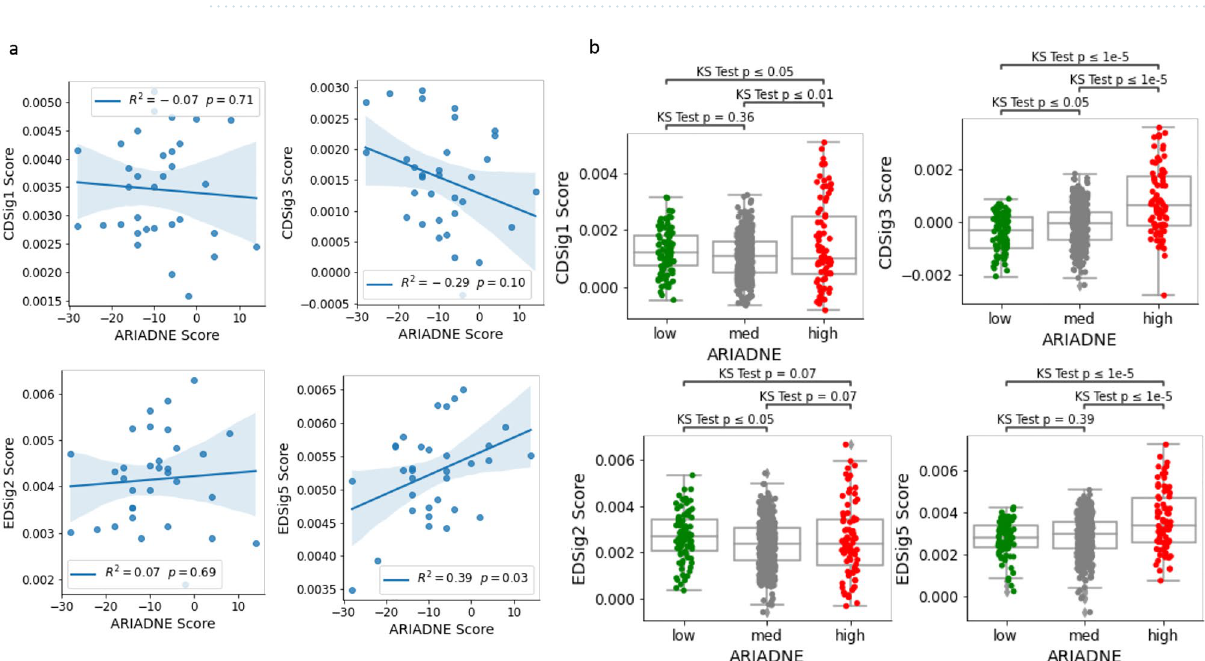
Figure 6. ARIADNE is associated with immune metasignatures in a large dataset. ( a ) Cross-correlation between immune metasignature scores and ARIADNE score for samples in the GSE88847 dataset. ( b ) Metasignature scores for groups classified according to the ARIADNE score for the GSE31519 dataset. Statistical significance is established using the KS